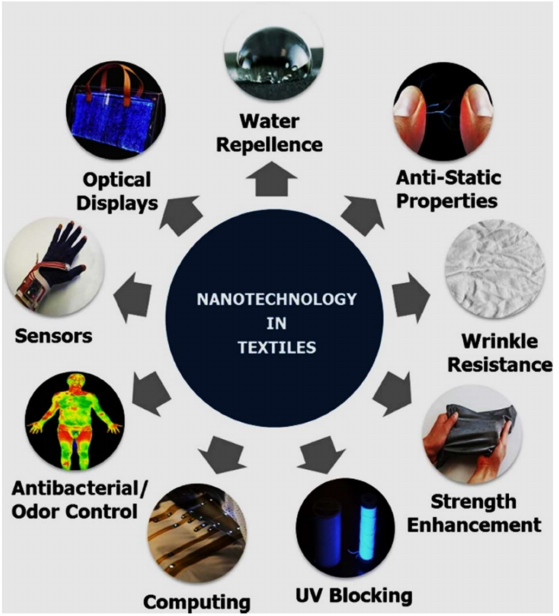
Figure 2. Various application of nanotechnology in e-textiles. Reprinted with permission from [57]. Copyright (2016) American Chemical Society.